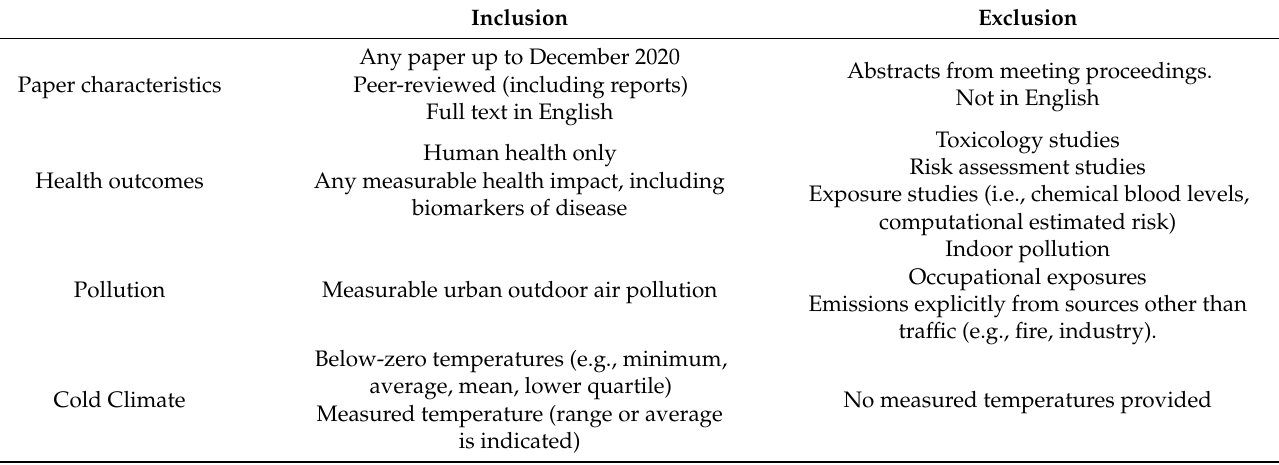
Table 1. Inclusion and exclusion